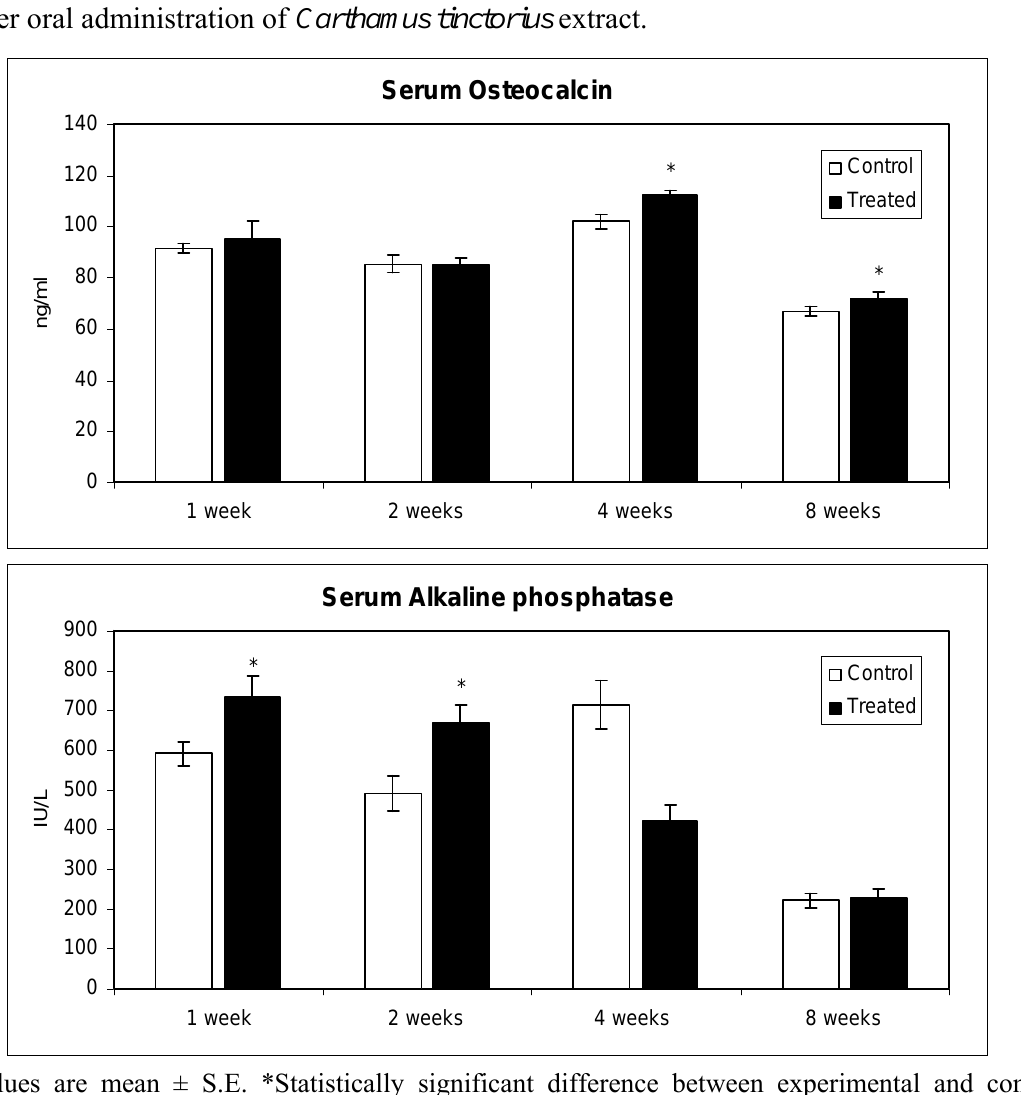
Values are mean ± S.E. *Statistically significant difference between experimental and control group by Student's t-test at 0.05. C: control group and T: administration of Carthamus tinctorius was started at age of 3 wks